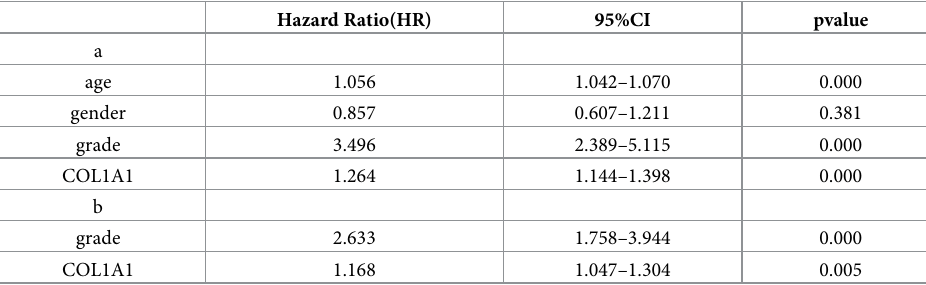
Table 1. Univariate (a) and multivariate analysis (b) of the correlation of COL1A1 expression with OS among LGG